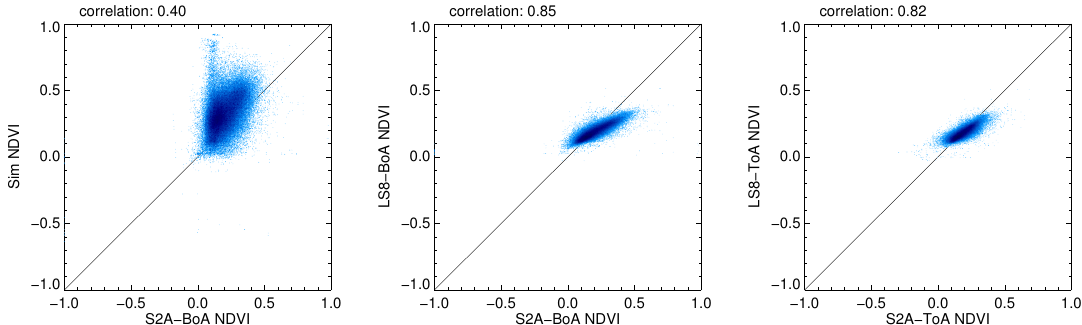
Figure 5. Scatterplots of the Normalized Difference Vegetation Index (NDVI) made with Landsat 8 OLI, Sentinel-2A MSI and a simulated Sentinel-2A MSI data cube. The figure on the left shows the scatter between the 2016 Sentinel-2A MSI bottom-of atmosphere (S2A-BoA) NDVI product and the 2004 simulated dataset (Sim). Note the relatively high values in the simulated datasets that are associated with the agricultural fields in the northeast of the scene. The centre figure shows the scatter between the 2016 Sentinel-2A MSI and Landsat 8 OLI bottom-of-atmosphere (S2A-BoA and LS8-BoA) products. The figure on the right shows the scatter between the Sentinel-2A MSI and Landsat 8 OLI top-of-atmosphere (S2A-ToA and LS8-ToA)